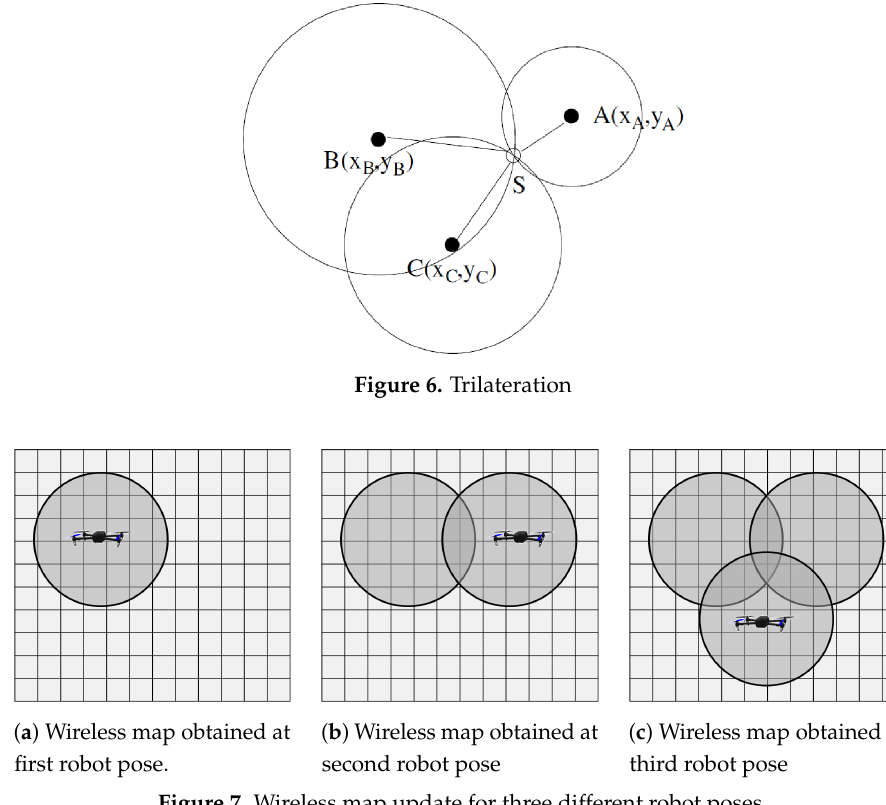
Figure 7. Wireless map update for three different robot